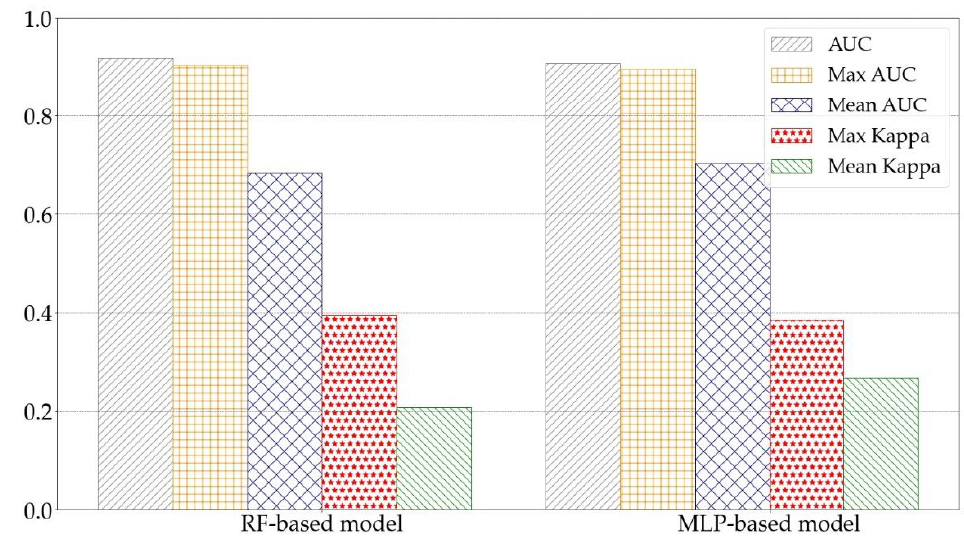
Figure 8. Comparison between the RF-based model and the MLP-based model. Figure 9 illustrates the settlement growth prediction maps of the different strategies that are based on the probability maps with the highest kappa coefficient.